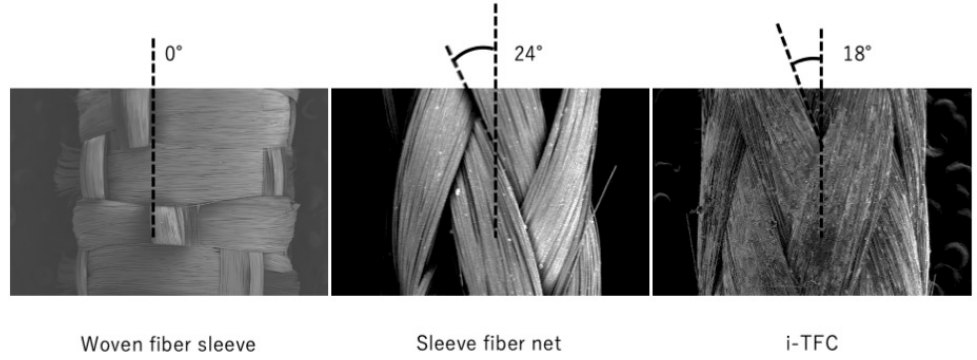
Figure 4. SEM images of the cross-sections of fracture surfaces for various specimens. The contemporary fiber posts available in the market are effective for the treatment of teeth in normal conditions and for most cases. However, in cases where flared root canals exist, conventional fiber post treatment may not be the optimal choice